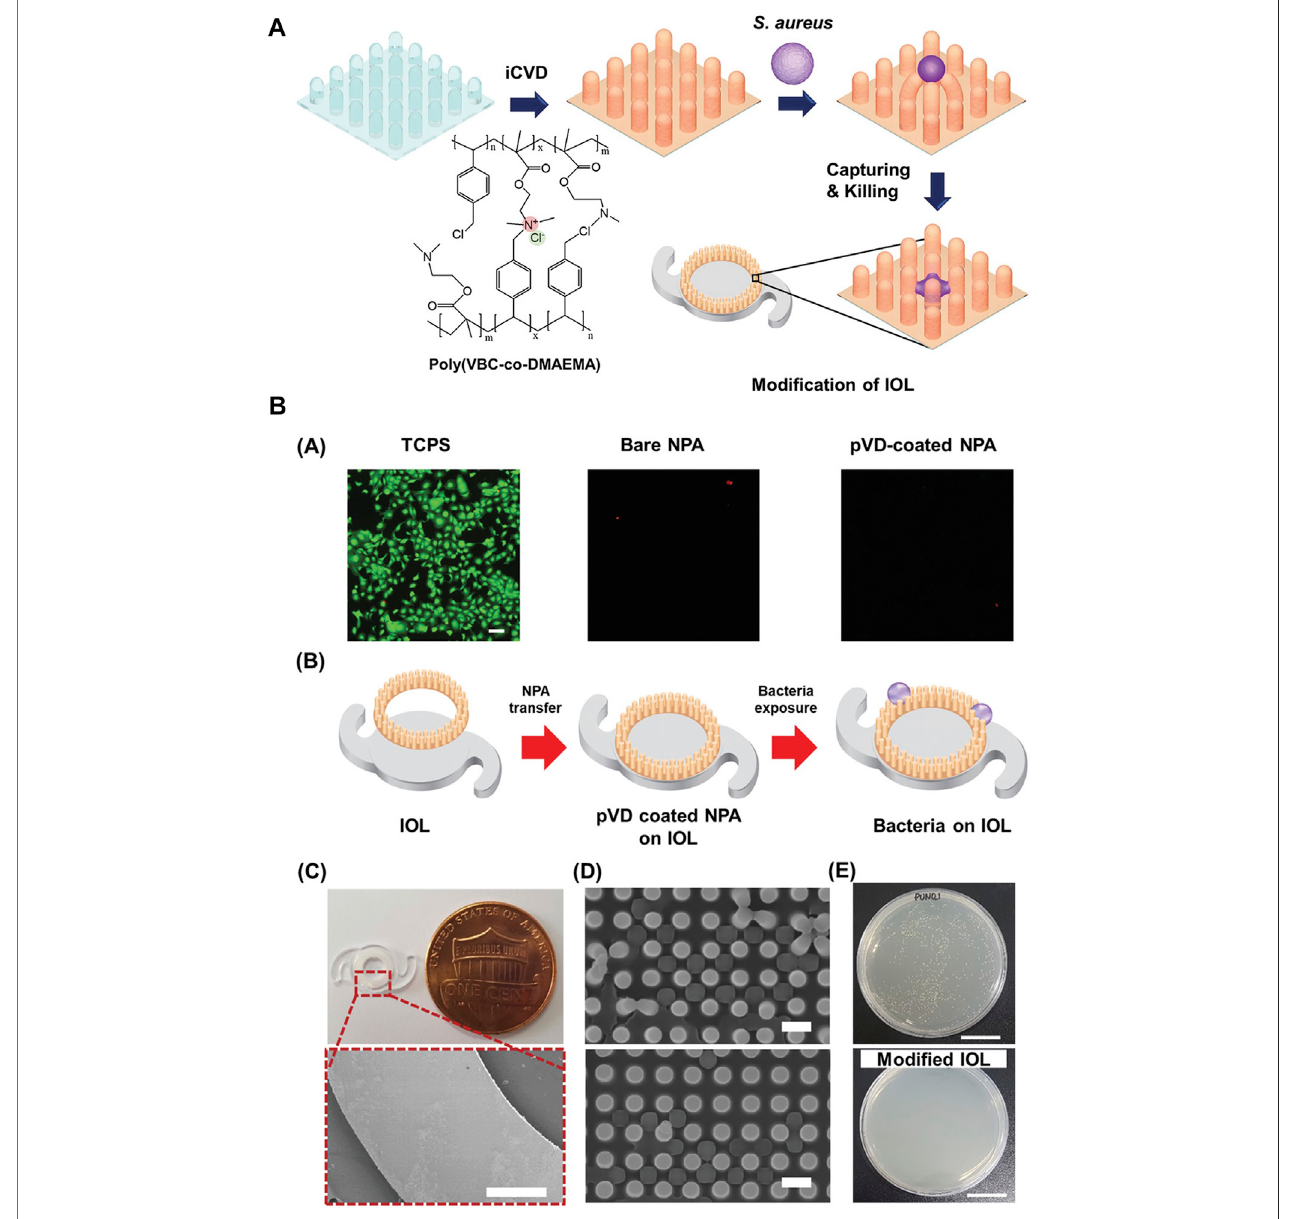
FIGURE 5 | (A) Schematic of the ionic polymer-coated NPA. (B) . (A) Live/dead staining and adhesion test of corneal endothelial cells on each NPA after a 1 day culture. There were no usable and adhered cells on the NPA due to the dimension of the NPA structure. The scale bar is 100 µm. (B – E) Modi fi cation of IOL with pVD- coated NPA fortheantibacterialproperty. (B) Schematicofthemonolithicintegration strategyofpVD-coated NPAontotheIOL. (C) Photographic image ofthemodi fi ed IOL and SEM images of the modi fi ed IOL edge. Scale bars are 500 µm. (D) SEM images of the NPA after exposure to S. aureus . Scale bars is 1 µm. (E) Representative images after colony-counting assay with control and modi fi ed IOL. The scale bars are 1 cm. Reprinted from Choi et al. (2020), with the permission of Wiley. NPA, polymeric nanopillar array; pVD, crosslinked ionic polymer thin fi lm.